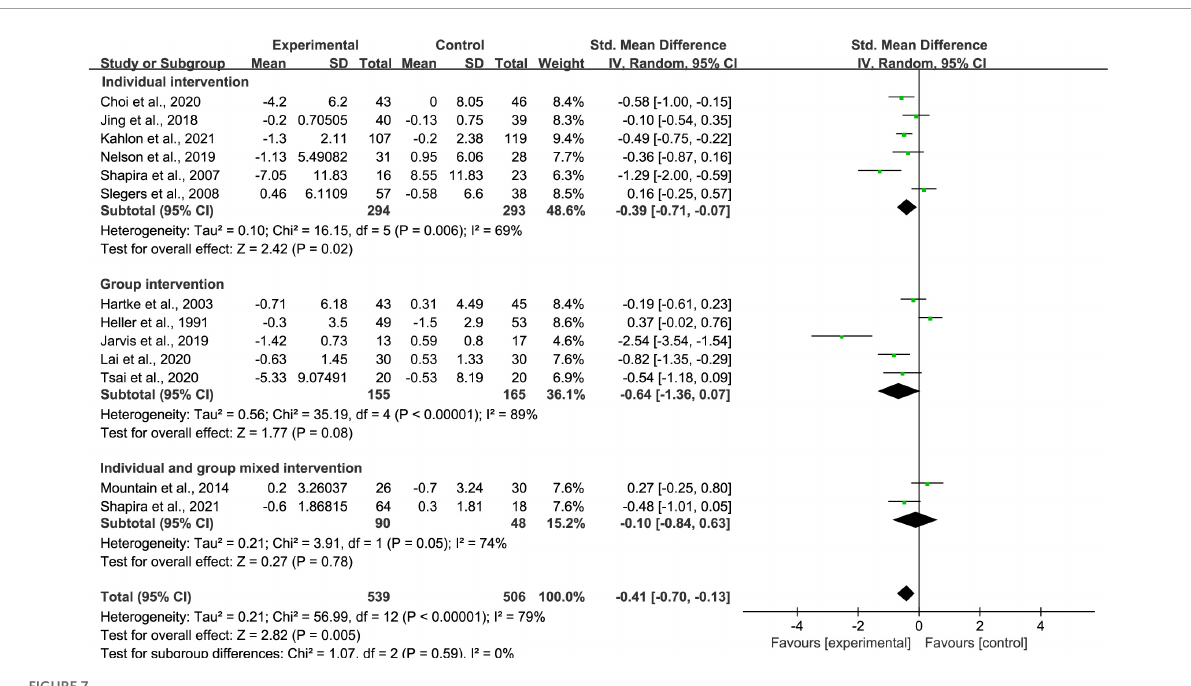
FIGURE7 Subgroup analysis: comparison of individual interventions, group interventions, or mixed interventions and all controls on the basis of loneliness scores.